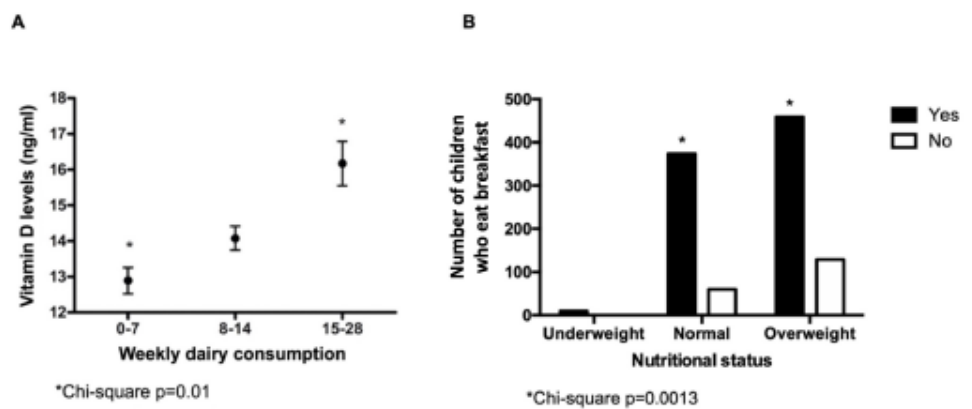
Figure 3. ( A ) Vitamin D levels according to average weekly dairy consumption. ( B ) Eating breakfast according to the nutritional status of children and adolescents included in the study.